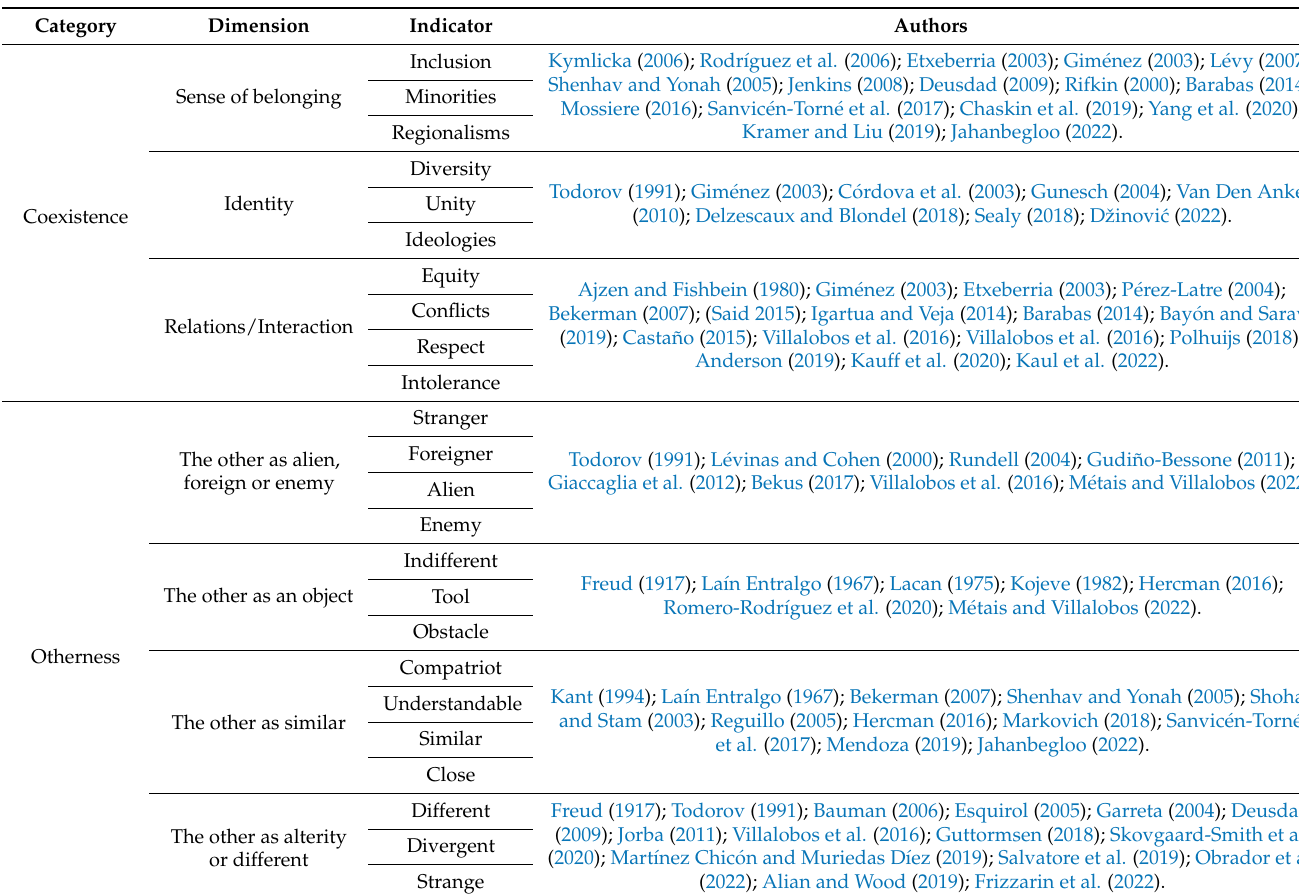
Table 2. Categories and